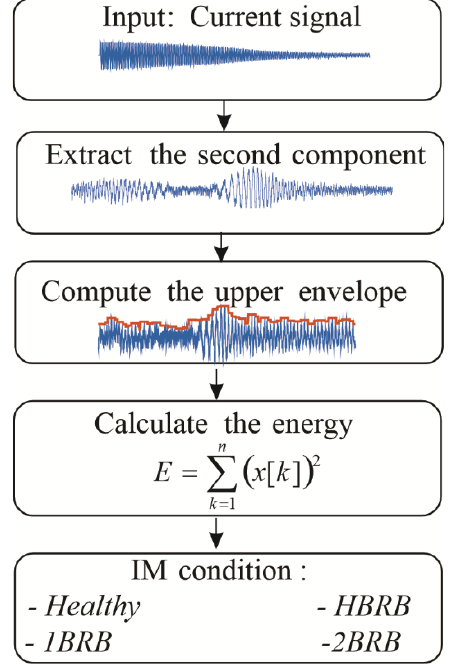
Figure 14. Proposed algorithm for the signal classification.